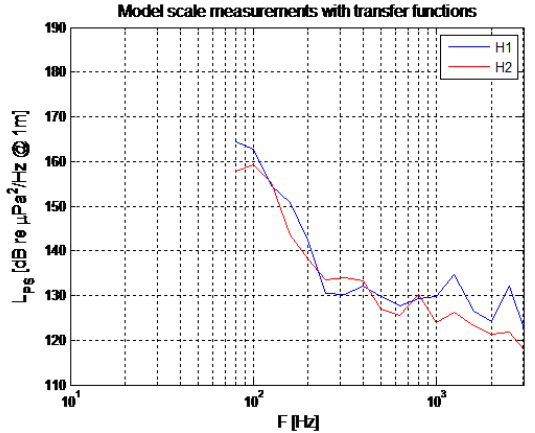
Figure 20: Cavitation tunnel noise prediction considering transfer